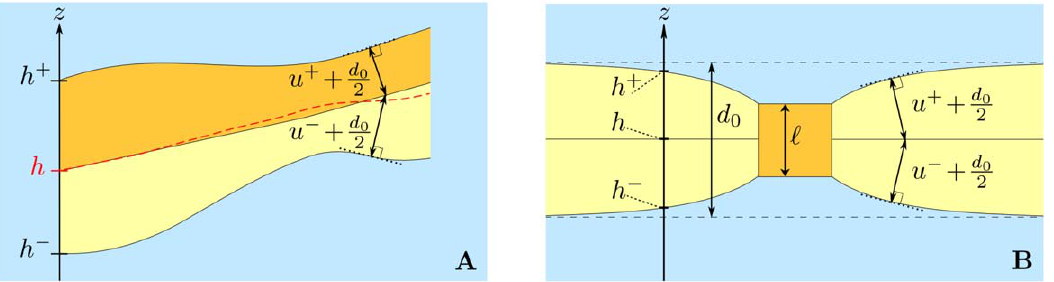
Figure 1. Definitions. A ) Cut of a bilayer membrane. The solid black lines mark the boundaries of the hydrophobic part of the membrane, and the exterior, which is shaded in blue, corresponds to the hydrophilic lipid heads and the water surrounding the membrane. The hydrophobic thickness, defined along the normal to the hydrophobic-hydrophilic interface, of the upper (resp. lower) monolayer, shaded in orange (resp. yellow), is u z z d 0 = 2 (resp. u { z d 0 = 2 ). The height of monolayer + along z is denoted by h + . The average membrane shape, h ~ ( h z z h { ) = 2 , is represented as a red dashed line. B ) Cut of a bilayer membrane (with hydrophobic part shaded in yellow) containing a protein with a hydrophobic mismatch (orange square). The equilibrium hydrophobic thickness of the bilayer is d 0 , while the hydrophobic thickness of the protein is ‘ . The average shape of the membrane is flat, and the thickness deformations of the two monolayers are identical ( u z ~ u { ~ u = 2 ). Hence, the average shape h is constant, and confounded with the midlayer of the membrane. Although u + is defined along the normal to the monolayer hydrophilic-hydrophobic interface, the boundary condition at the inclusion edge, i.e., in r ~ r 0 , simply reads u ( r 0 ) ~ u 0 ~ ‘ { d 0 to first order (see main text, Section entitled ‘‘Deformation profiles close to a mismatched